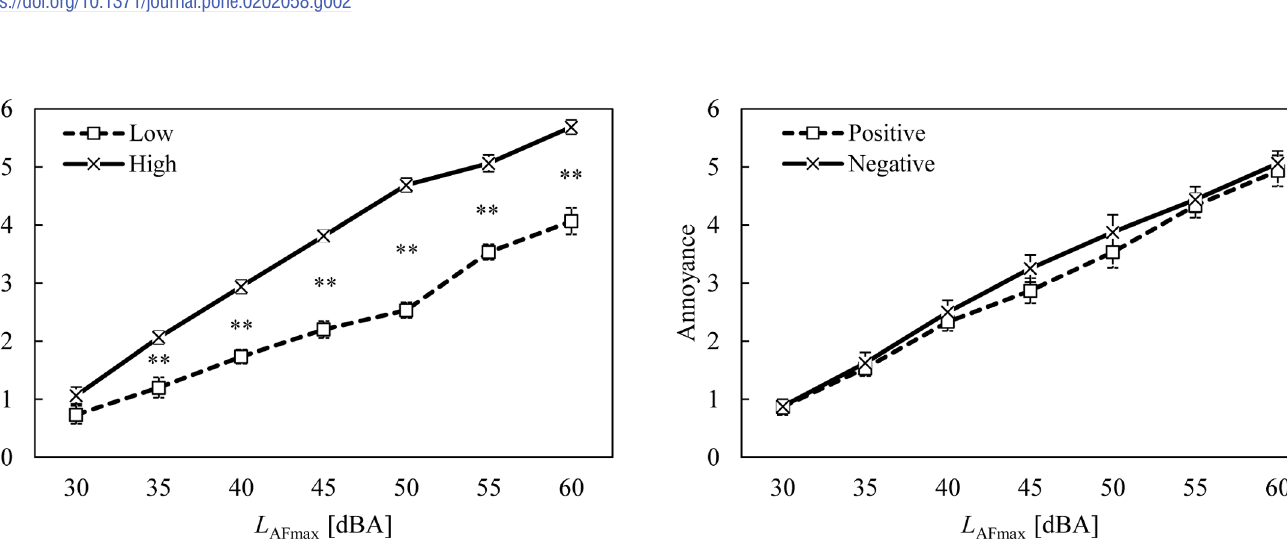
PLOS ONE | https://doi.org/10.1371/journal.pone.0202058 August 13,